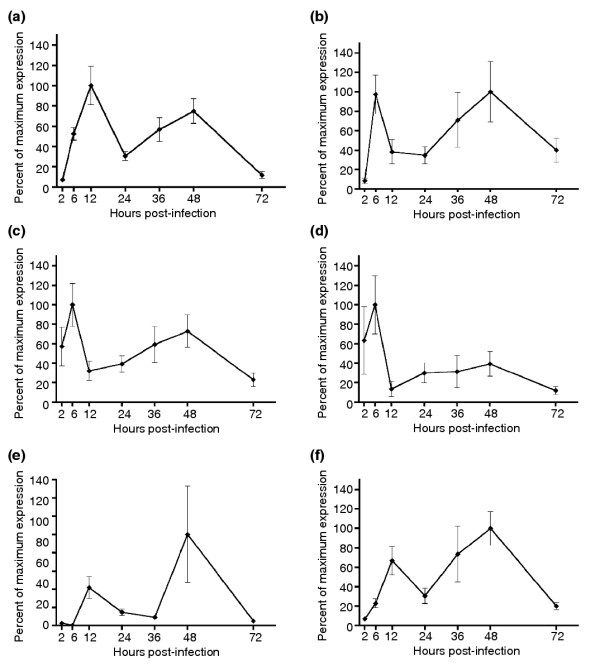
Expression profiles of select genes in C. parvum-infected HCT-8 cells. The expression level of each gene is calculated as the ratio of its RT-PCR product to that of C. parvum 18s rRNA. (a) glucose-6-phospate isomerase; (b) leucine aminopeptidase; (c) pteridine transporter (BT-1); (d) tyrosyl-tRNA synthetase; (e) calcium-dependent protein kinase; (f) dihydrofolate reductase-thymidine synthetase (DHFR-TS). The genes examined in (a-c, e) represent transferred genes of different origins; (d, f) represent non-transferred references. Error bars show the standard deviation of the mean of six independent time-course experiments.